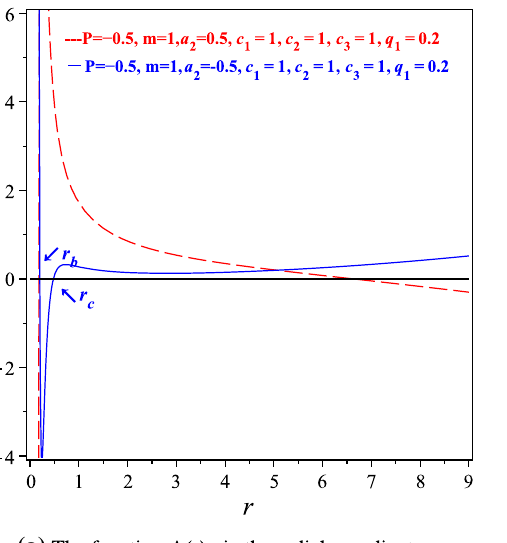
( a ) (b) Fig. 1 Schematicplotofhorizonsofsolution(33).Theplotof a shows a 1 = 1. The units are in terms of the event horizon r b assumed equal to theblackholeeventhorizon, r b ,andthecosmologicalhorizon, r c ,while 1. In other words, the plots are in terms of Schwarzschild gravitational radius r g = 2 GM / c 2 ruled by the mass of the black of b shows the horizon-mass radius relation. Here we take d = 4 and